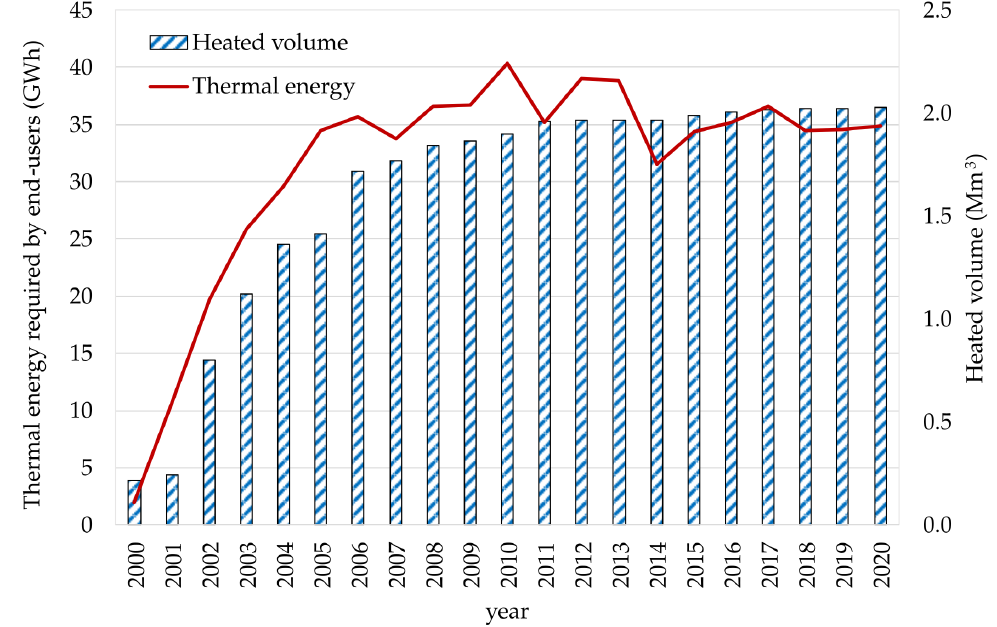
Figure 2. Thermal energy required by end-users and heated volume